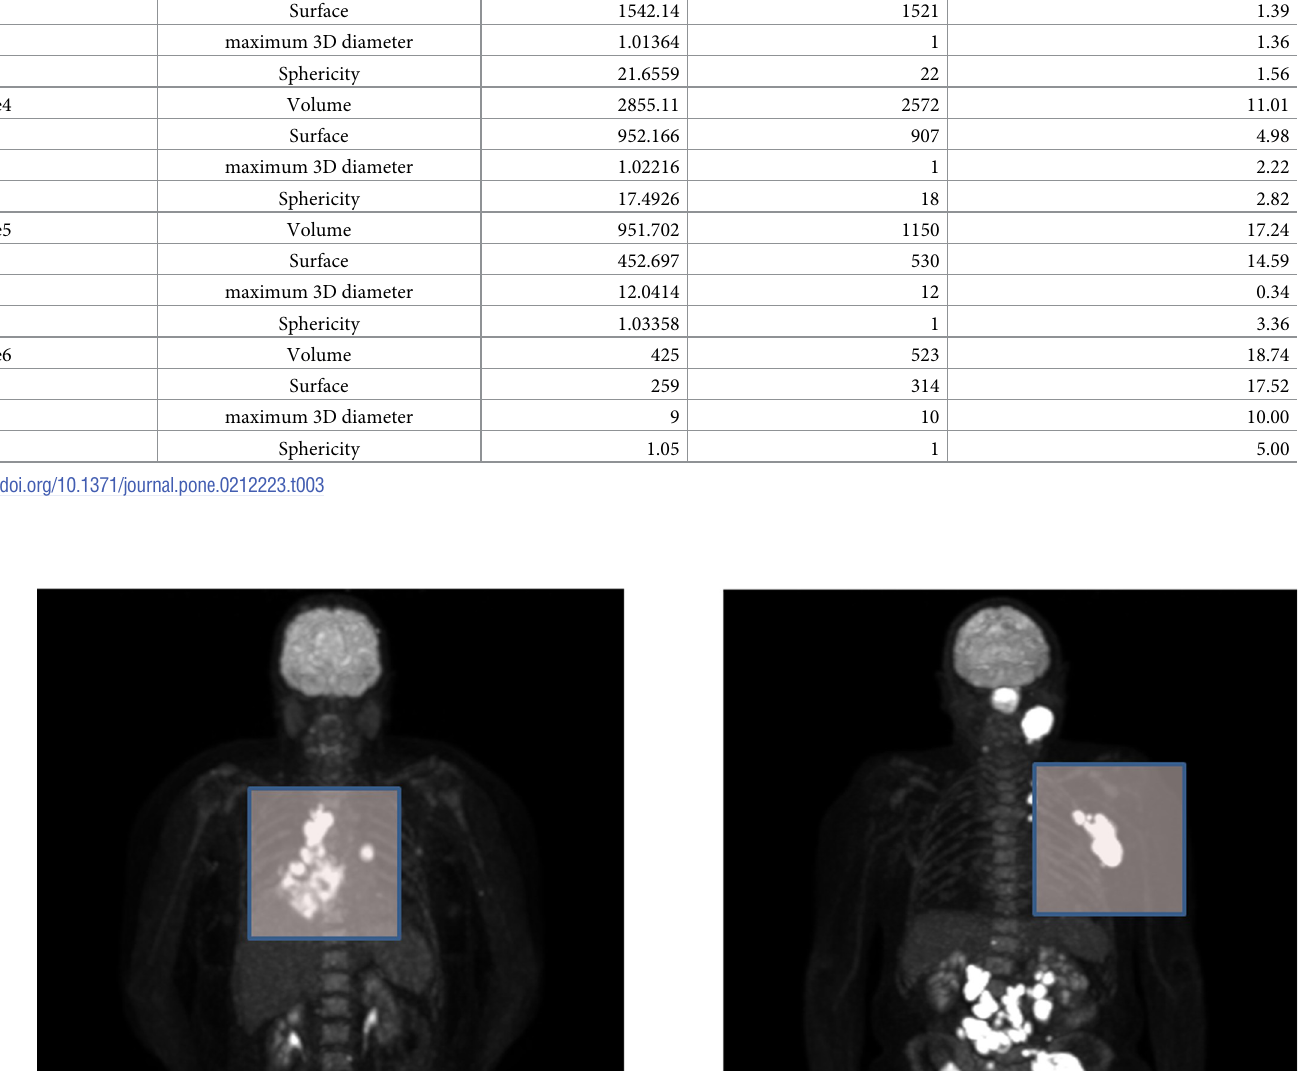
PLOS ONE | https://doi.org/10.1371/journal.pone.0212223 February 20,